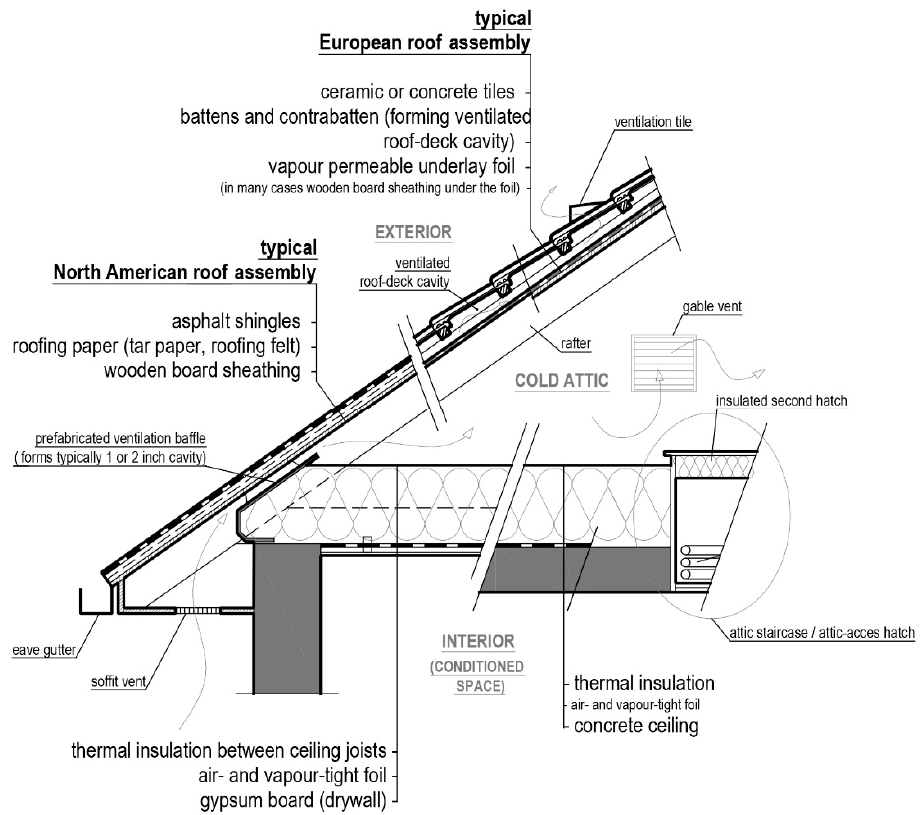
Figure 1. Glossary scheme of a cold attic with typical North American and European roof-deck assemblies.